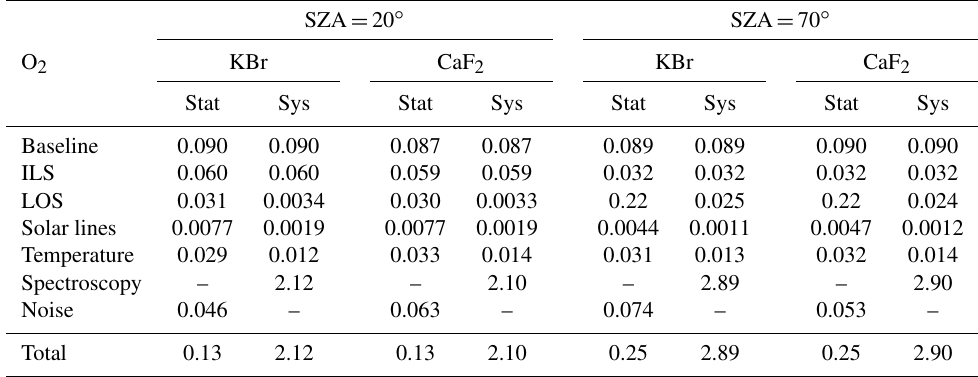
Table 4. Mean ensemble values of the statistical (Stat) and systematic (Sys) errors for 20 and 70 ◦ (given in %) in O 2 columns due to the assumed error sources of Table 2.